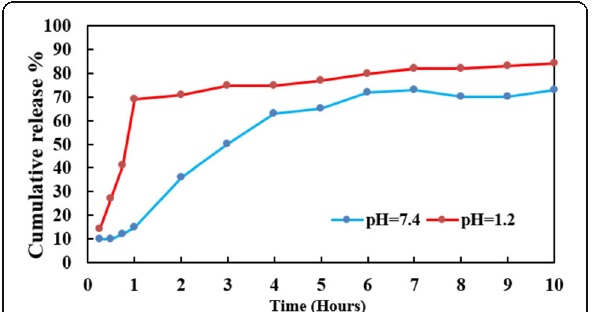
Fig. 1 In vitro release profiles of RES from SLN-RES in acidic and natural